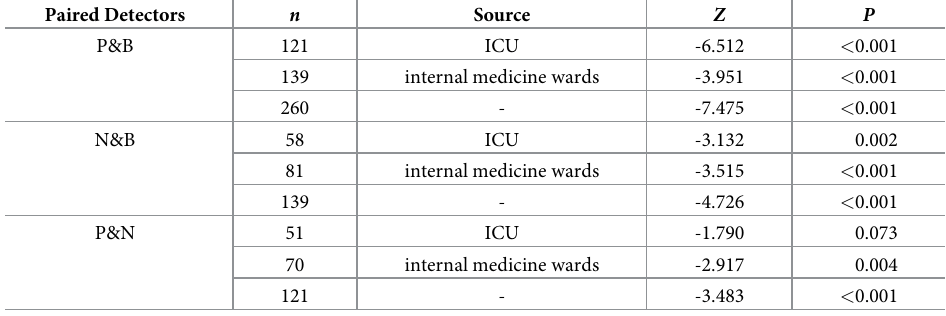
Table 4. Comparison of the ATP content values (10 -17 mol) measured using different detectors, using the Wil- coxon signed-rank test. Paired